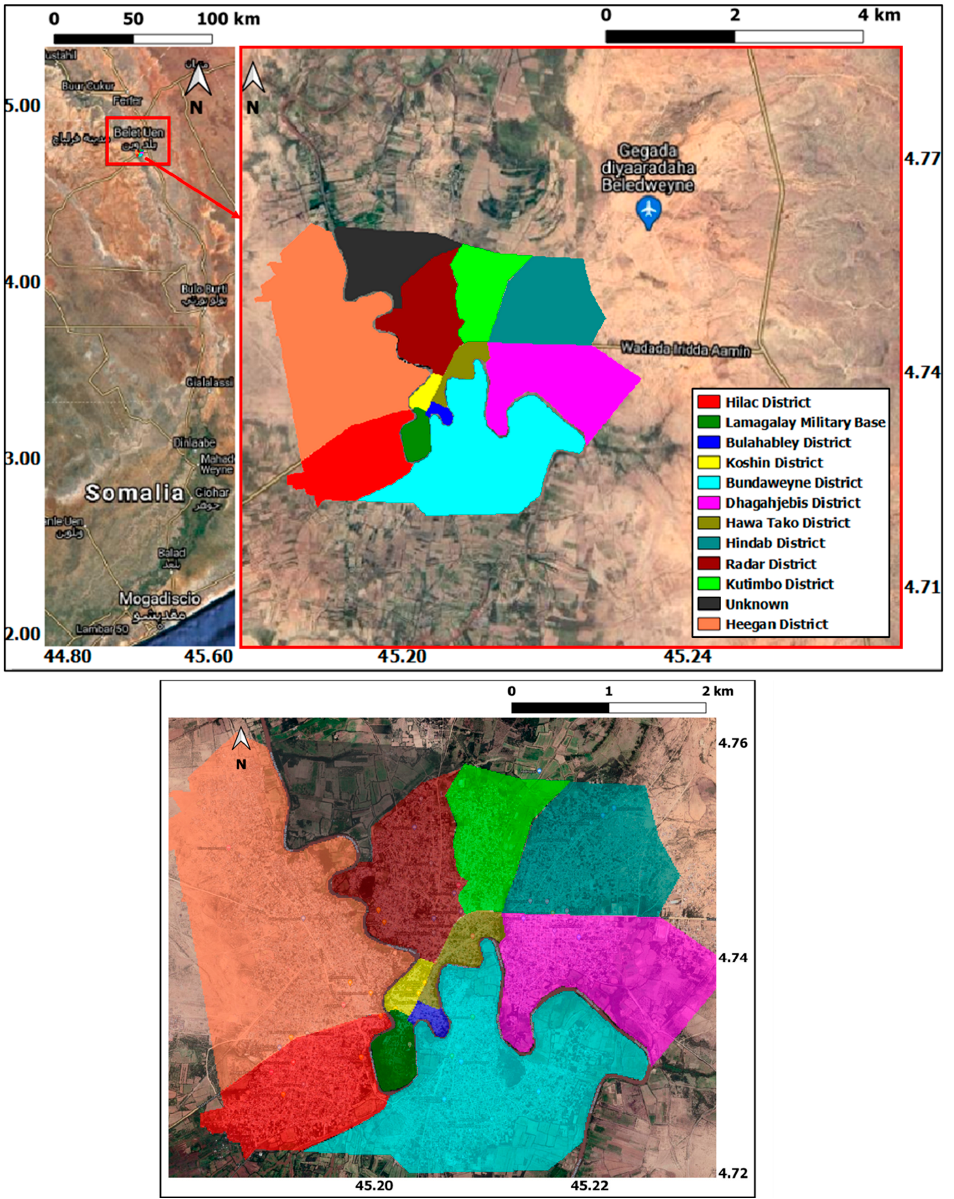
Figure 1. Geographic location of Beletweyne (left panel) and main districts of the town (derived from the maps available at https://unitar.org/maps/map/3054). The lower panel is a zoom on the urban area, where the districts are shown with transparency.